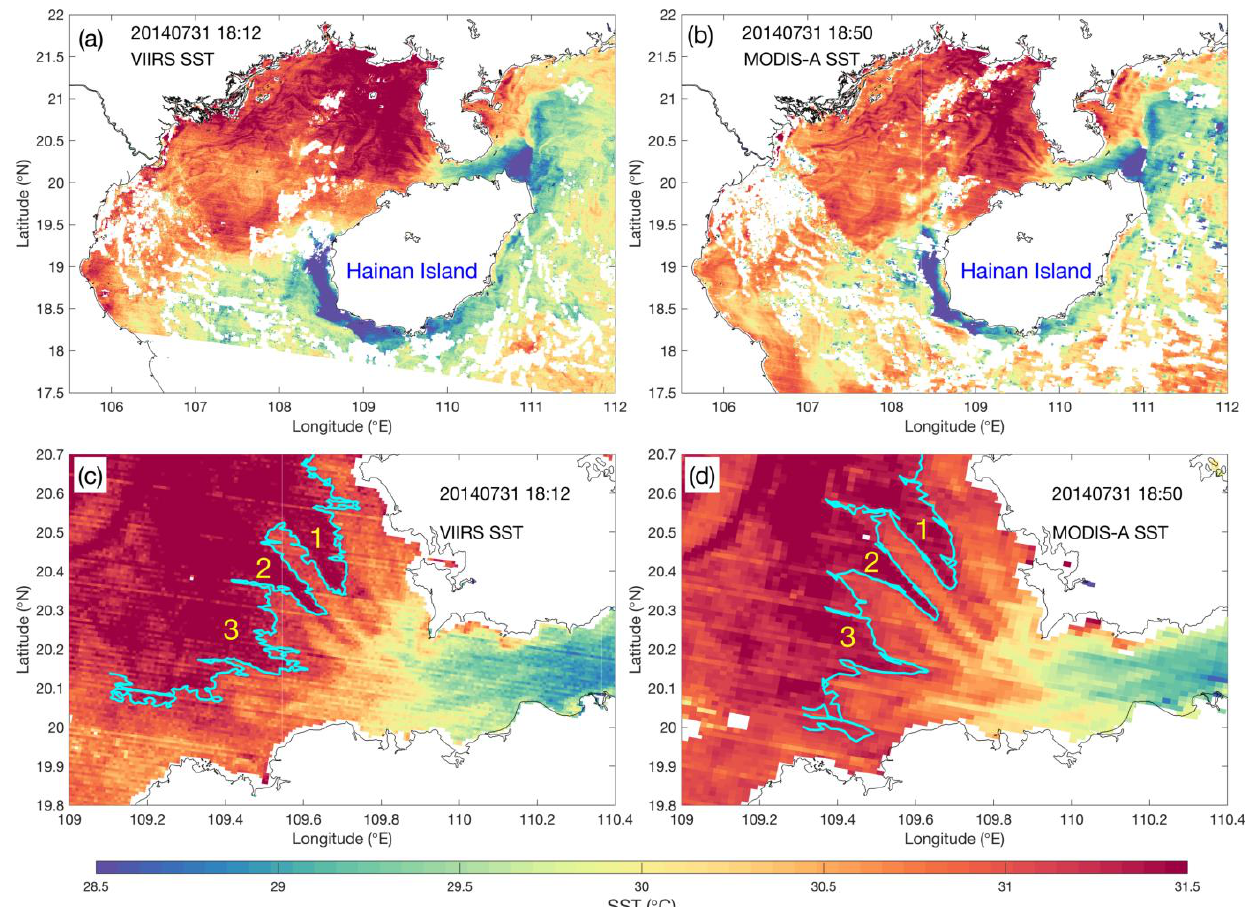
Figure 3. Level-2 SST observations from VIIRS ( a ) and MODIS-A ( b ) at 18:12 UTC and 18:50 UTC on 31 July 2014, respectively. ( c , d ) are magnified views of ( a , b ) over the western entrance area of QS, respectively. Cyan contours display the 31.2 °C isotherms, marking off warm water tongues’ peripheries. Note: “1”, “2”, and “3” are used to mark off three branches of the observed trident-shaped warm water tongue, respectively.